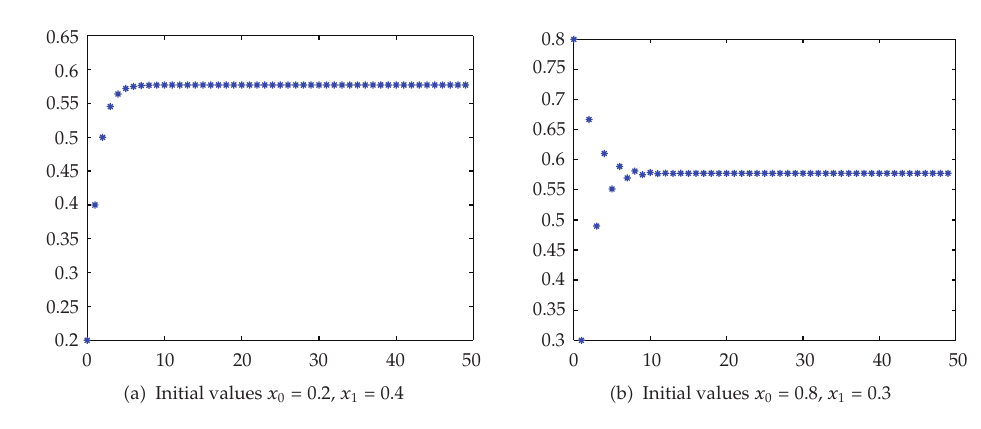
Figure 3: r (cid:5) 1, q (cid:5) 2; x ∗ (cid:5)